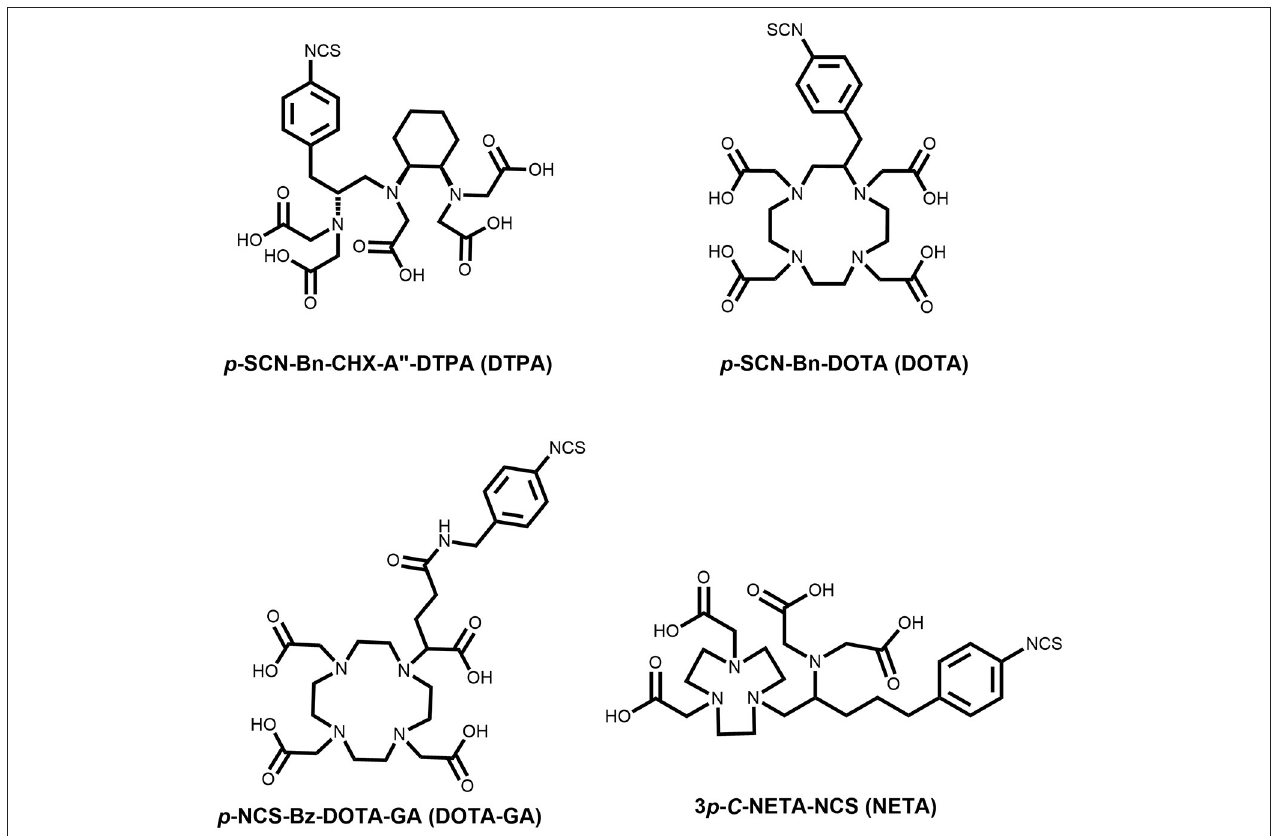
FIGURE 1 | Chemical structure of bifunctional chelators used in this